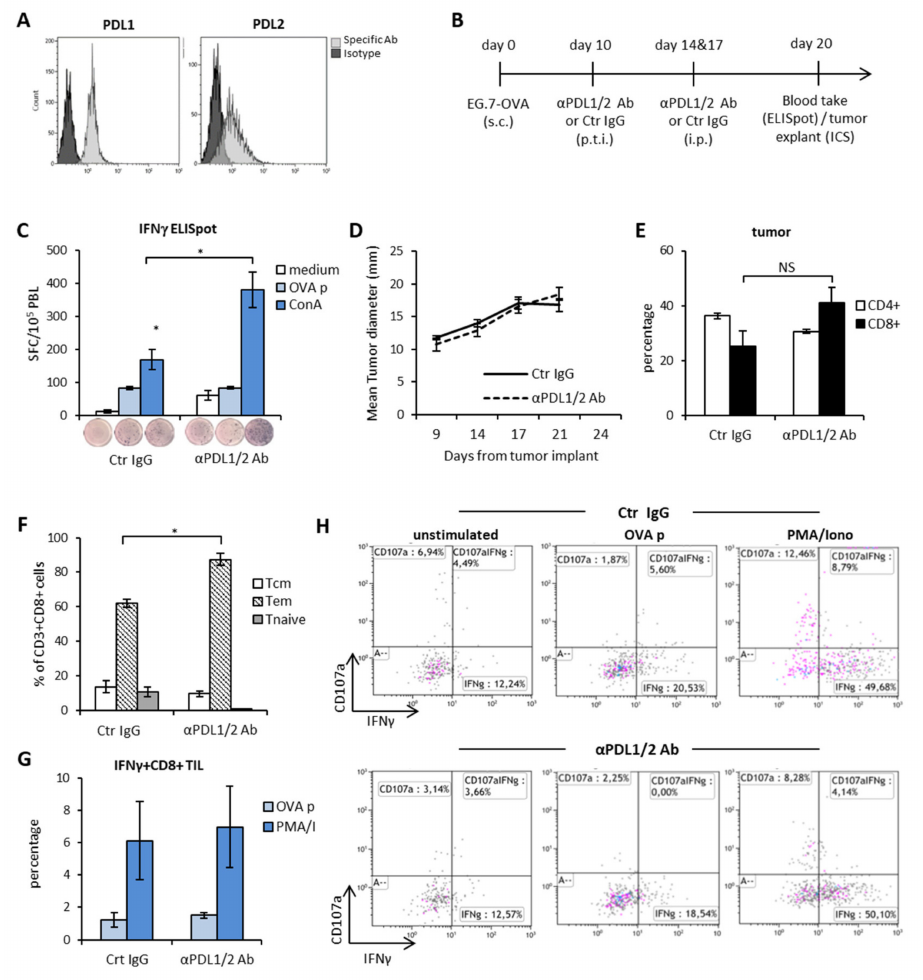
Figure 1. The PD1-PDL axis blockade enables systemic immune activation, but poor tumor-specific reactivity and therapeutic outcome in a highly immunogenic tumor model. ( A ) Expression of PDL1 and PDL2 molecules on EG.7-OVA cells in vitro. ( B ) Schematic representation of the experimental design. ( C ) IFN γ -ELISpot on blood leukocytes (PBL) collected 3 days after the last injection with anti-PDL1 + anti-PDL2 Abs or Control IgG (Crt IgG) and incubated o.n. with the indicated stimuli. Data are represented as mean ± SEM. Representative wells from each condition are shown. ( n = 5) ( D ) Mean tumor size of mice treated with anti-PDL1 + anti-PDL2 Abs or Crt IgG ( n =